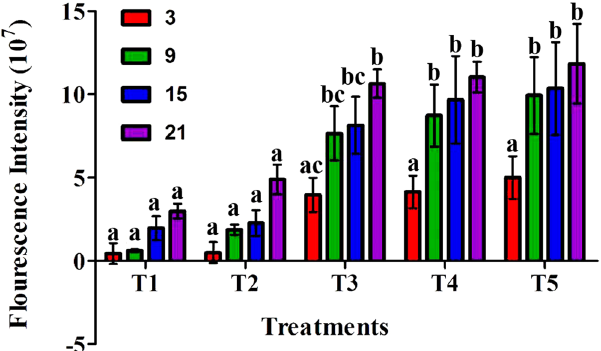
Figure 4. Nile red fluorescence intensity (expressed as 10 7 cells ml − 1 ) produced by D. salina grown over 21 d, with T1 to T5 respectively at different NaCl levels (0.5, 1. 1.5. 2 and 2.5 M). The analysis was done by two-way ANOVA considering Bonferroni post-tests to compare the means of the replicates; different labels at the bars show significant variation at P ≤